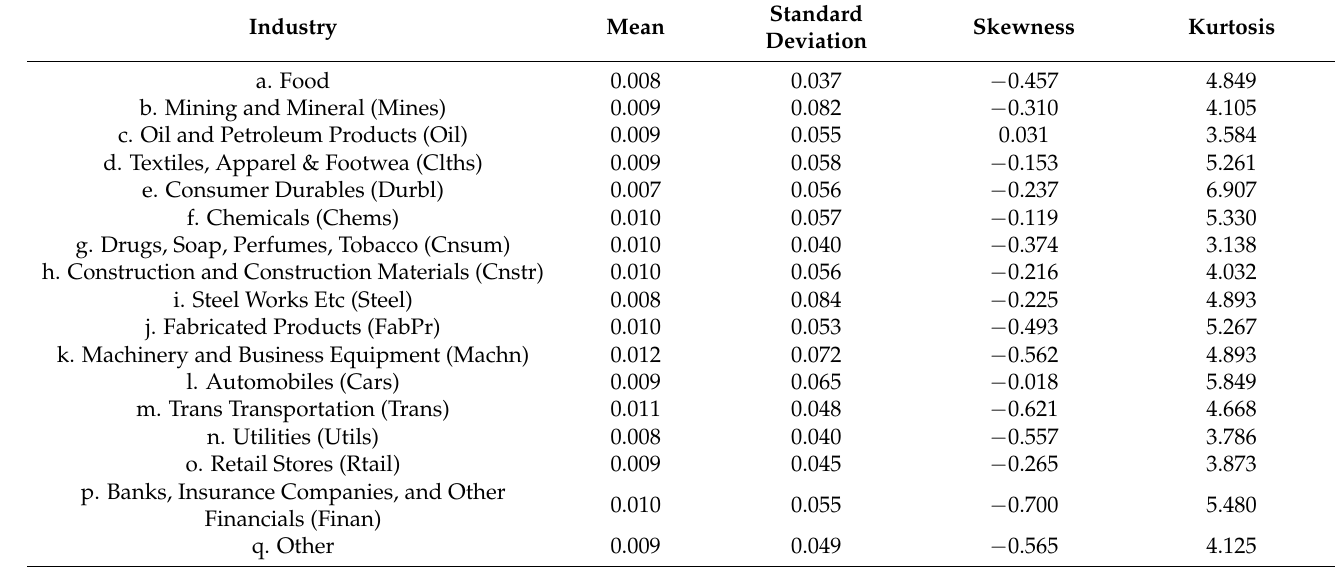
Table A1. Summary statistics about 17 industry portfolios from October 1992 to September